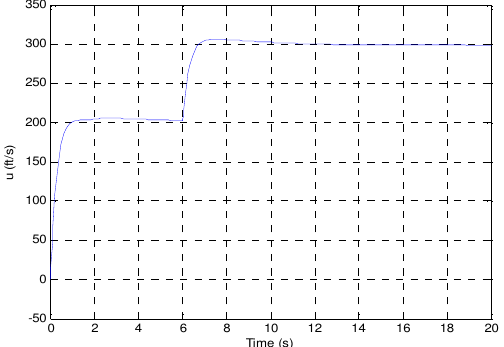
Fig. 7. Airspeed with step throttle input.